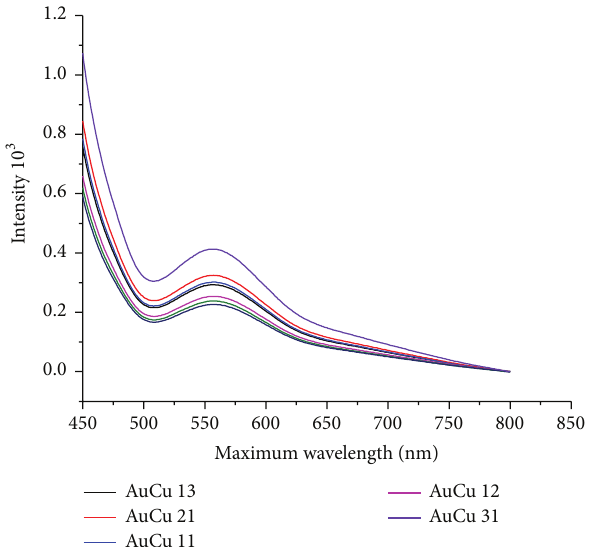
Figure 7: XRD spectra for samples Au-Cu 3 :1, Au-Cu 2 :1, Au-Cu 1: 1, Au-Cu 1: 2, and Au-Cu